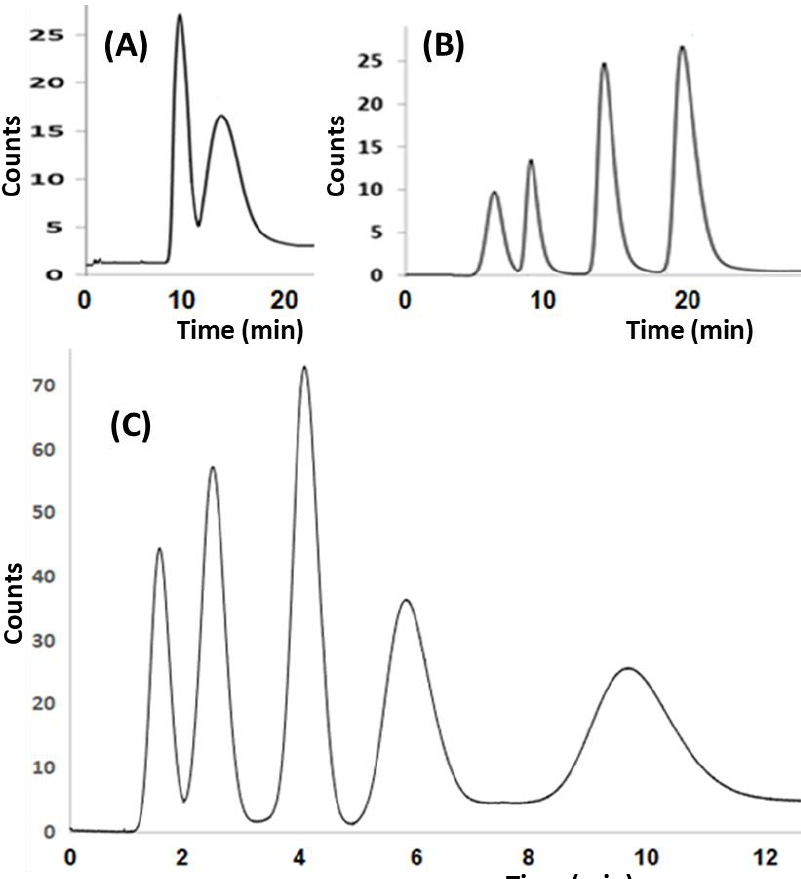
Figure 7. HPLC separation of the ketone mixture under the optimal conditions using GMA ( A )